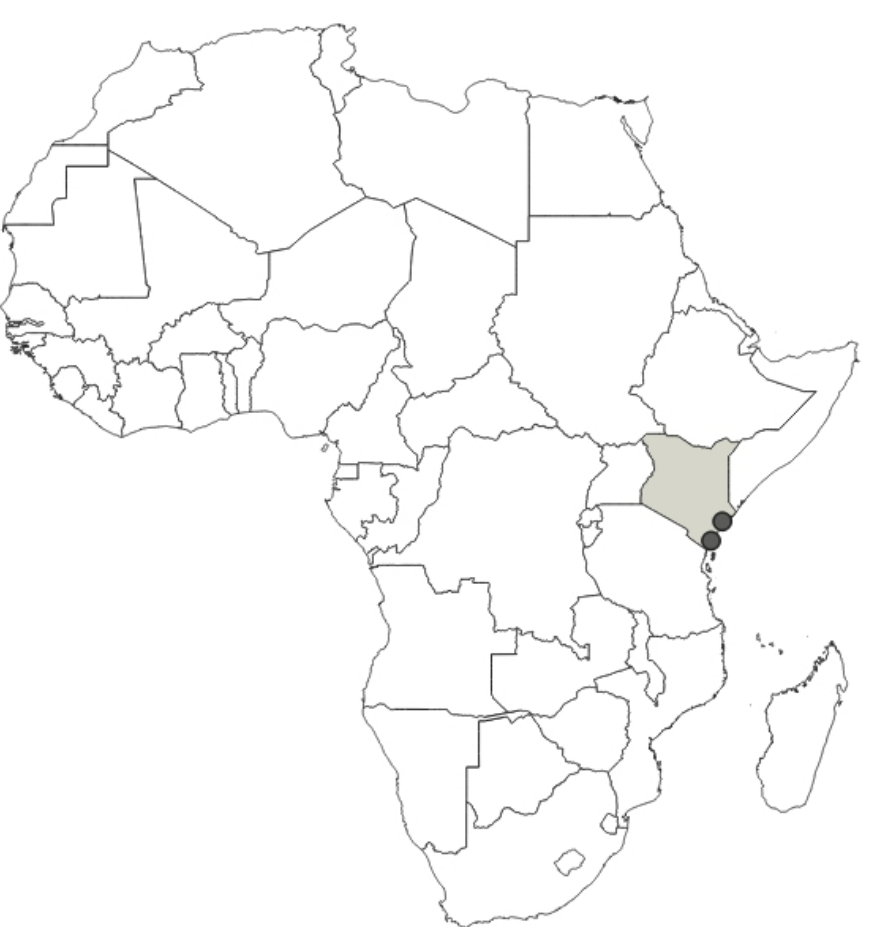
Figure 48. Known distribution of Phonoctonus luridus Miller,